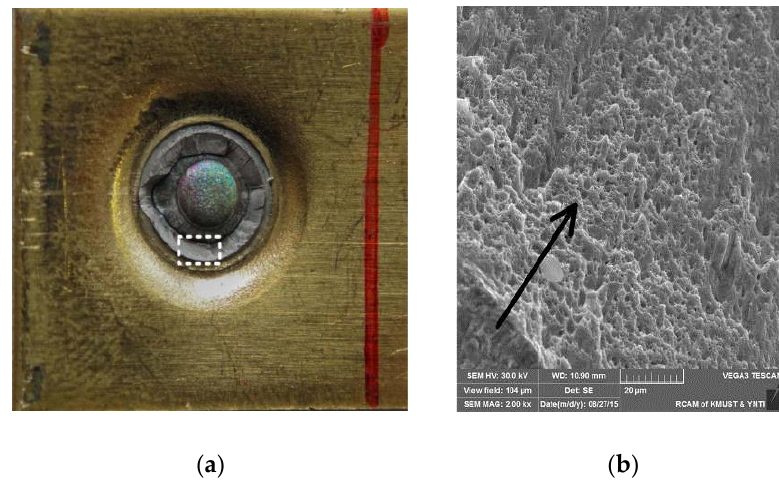
Figure 8. SEM (scanning electron microscopy) images of fracture surface for the STH specimens (load level of 35%). ( a ) Fracture surface of the rivet; ( b ) Enlarged fracture area.